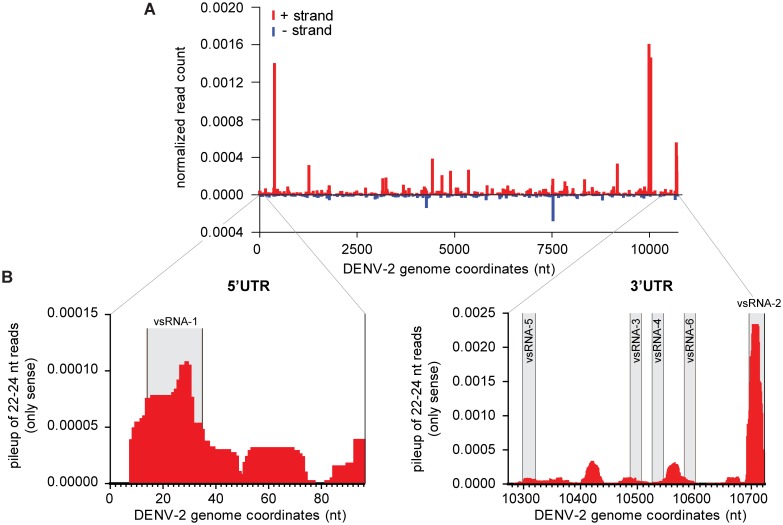
DENV miRNA-like small RNAs are not produced in infected Aag2 cells.(A) Distribution of 22–24 nt RNA reads across the DENV genome. Red bars indicate the number of 5’ ends of small RNAs that map to the (+) strand of the genome, blue bars represent the small RNAs mapping to the (-) strand. Read counts were normalized to the size of the corresponding library and the mean of the three libraries is plotted. (B) Pile-up of 22–24 nt small RNAs mapping to the (+) strand of DENV2 5’ (left panel) and 3’ UTRs (right panel), respectively. The mean of the three libraries is shown. Grey shadings highlight the boundaries of the mature DENV2 vsRNA sequences as reported in [24].